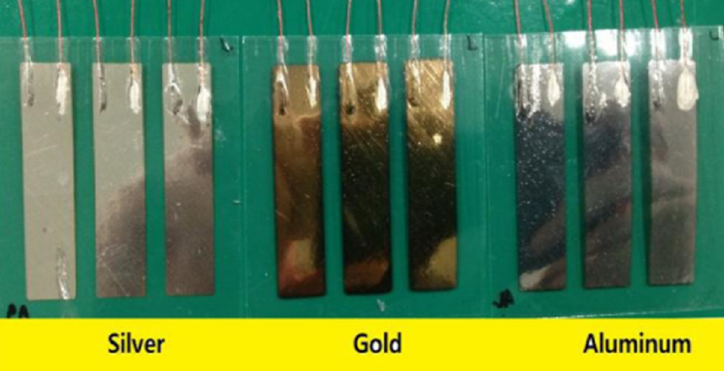
Figure 16. Fabricated gold, silver and aluminum electrode electroactive paper specimens [81].